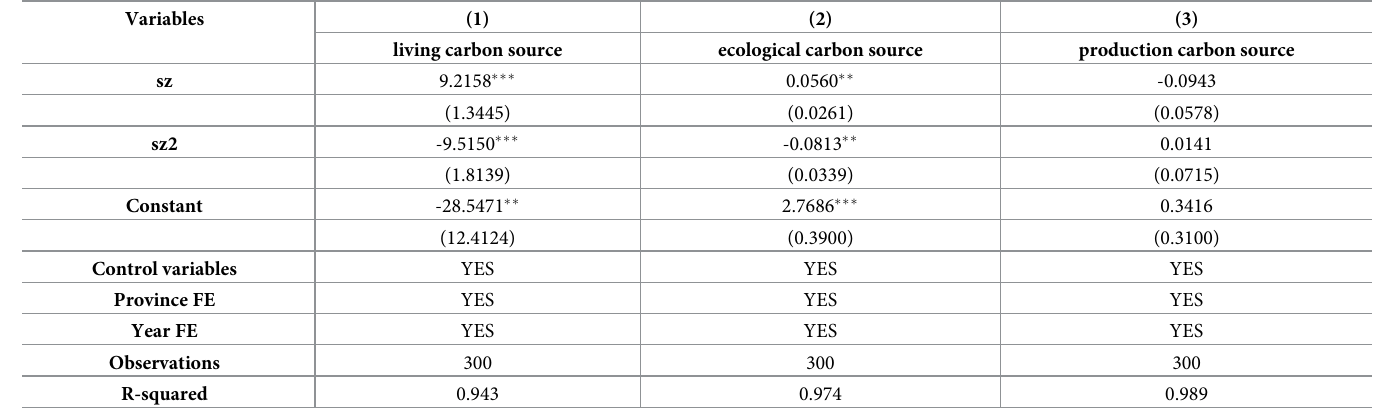
Table 5. The impact of digital villages on carbon emissions in various dimensions.